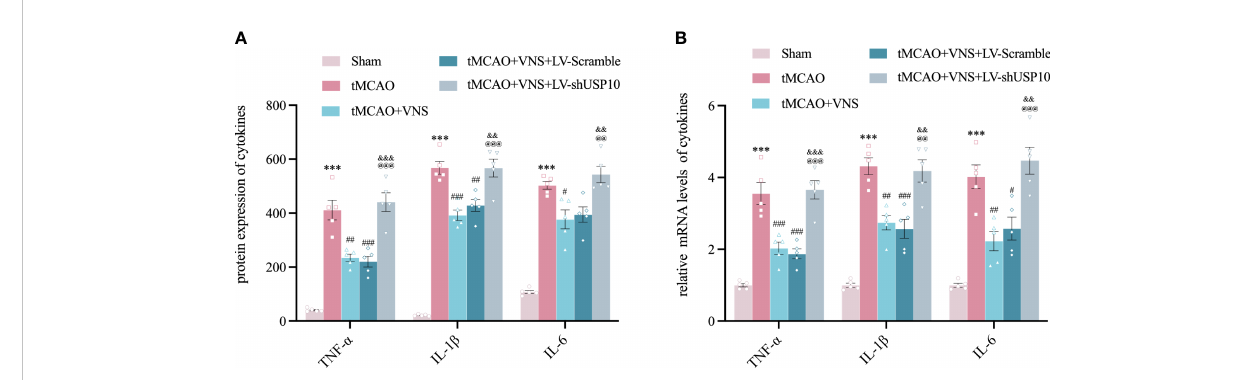
FIGURE 7 Silencing USP10 reversed the inhibitory role of VNS on in fl ammatory cytokine expression. (A, B) The expression of TNF- a , IL-1 b , and IL-6 in the cerebral cortex ’ s ischaemic penumbra were detected by ELISA (A, n=6) and RT-qPCR (B, n=6). Data are mean ± SEM. ***P<0.001 vs. Sham group, ###P<0.001, ##P<0.01 and #P<0.05 vs. tMCAO group. @@@P<0.001 and @@P<0.01 vs. tMCAO+VNS group. &&&P<0.001, and &&P<0.01 vs. tMCAO+VNS+ LV-Scramble